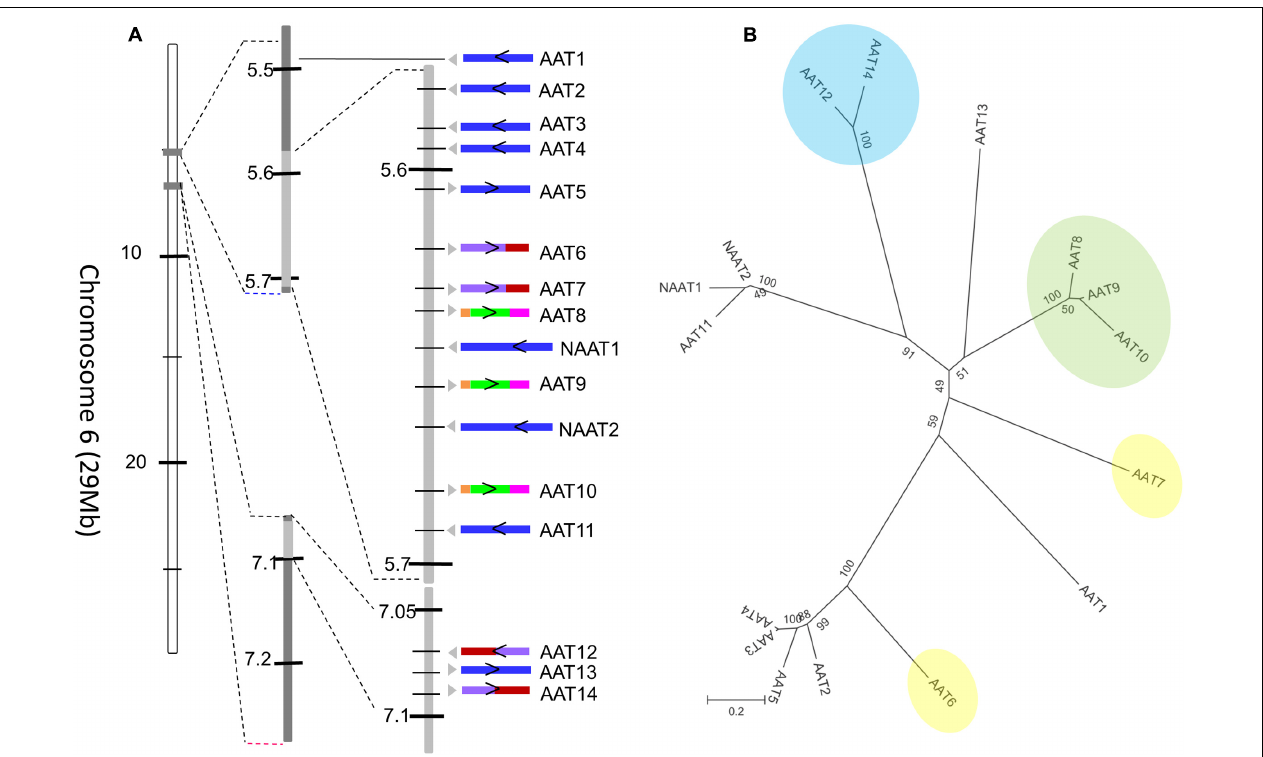
FIGURE 5 | Amaranthin-like proteins in C. sativus . (A) Distribution of AAT sequences on chromosome 6 of cucumber. The arrow indicates the direction of the gene on the chromosome. The intron/exon composition is shown with colors. Sequences without intron are colored in blue; sequences with one intron are in purple (the first exon) and red (the second exon); sequences with two introns are in orange (the first exon), green (the second exon), and pink (the third exon). (B) Phylogenetic tree of all amaranthin-like genes in cucumber. Sequences with similar intron/exon composition are marked with same color. Numbers next to nodes indicate bootstrap